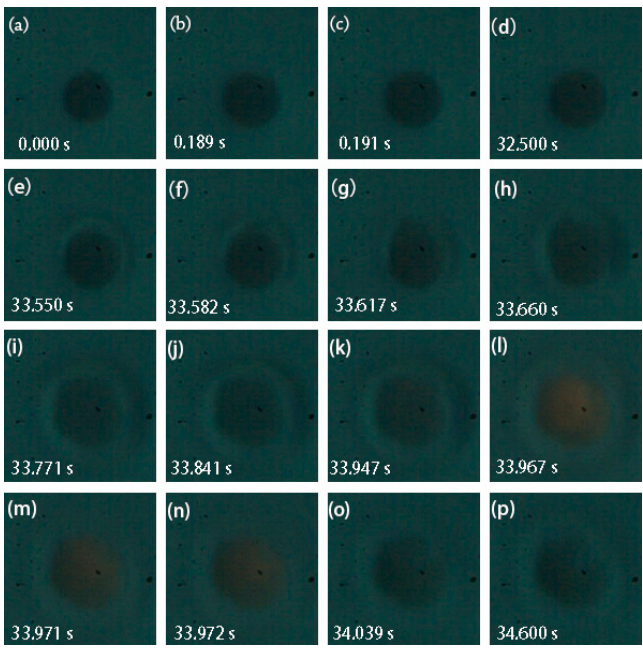
Figure 3. Representative snapshots of laser ‐ induced ignition and combustion processes of an individual aluminum particle. The diameter was 6.82 μ m. The laser power density was 5.88 × 10 5 W/cm 2 . (Images acquired from Supplementary Materials, Video S1; recording frame: 11,000 fps; exposure time: 90.9 μ s).